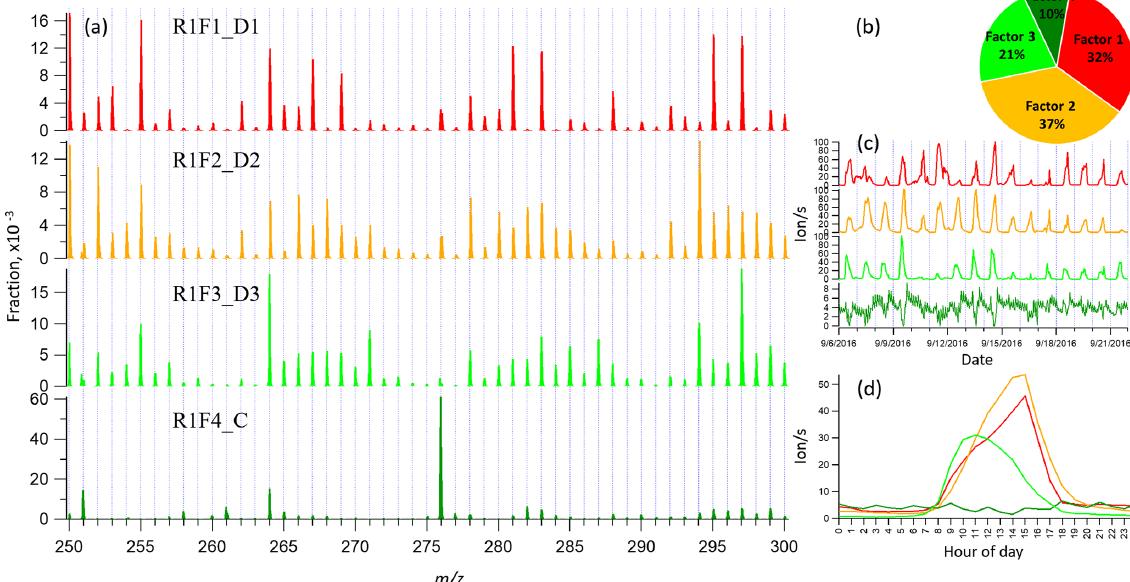
Figure 2. Four-factor result for Range 1 for (a) factor spectral profiles, (b) averaged factor contribution during the campaign, (c) time series, and (d) diurnal trend. Details on the naming schemes for the factors are shown in Table